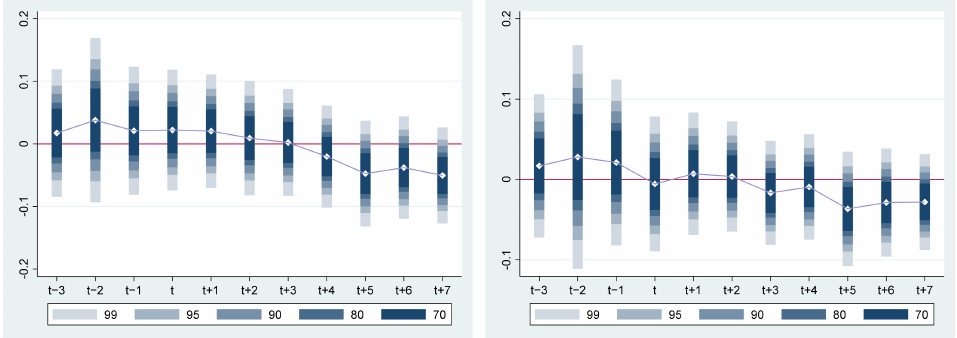
Figure 3. Dynamic effect of parallel trend